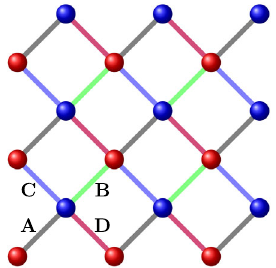
FIG. 16. Entanglement rate for the S configuration with OBC and Haar random 2-qubit gates from U(4). In the TDL, one has FIG. 17. Qubit connectivity used in Google ’ s quantum proc- essor Sycamore. Dots represent qubits, and lines are different 2- j λ 2 j ¼ ð 4 = 5 Þ 2 ; however, the entanglement rate is due to a phantom eigenvalue equal to r ln ð 3 = 2 Þ . The three dashed qubit gates. We focus on lattices of 3 × m qubits (we show m ¼ 6 , E ¼ − log λ lines in panel (a) show r giving n ¼ 18 ). Gates labeled with the same letter (and color) are 2 j , using the conjectured 2 j E ¼ executed simultaneously (see text for cos ð π =n Þ(cid:2) 2 . finite-size expression j λ 2 j ¼ ½ 4 5